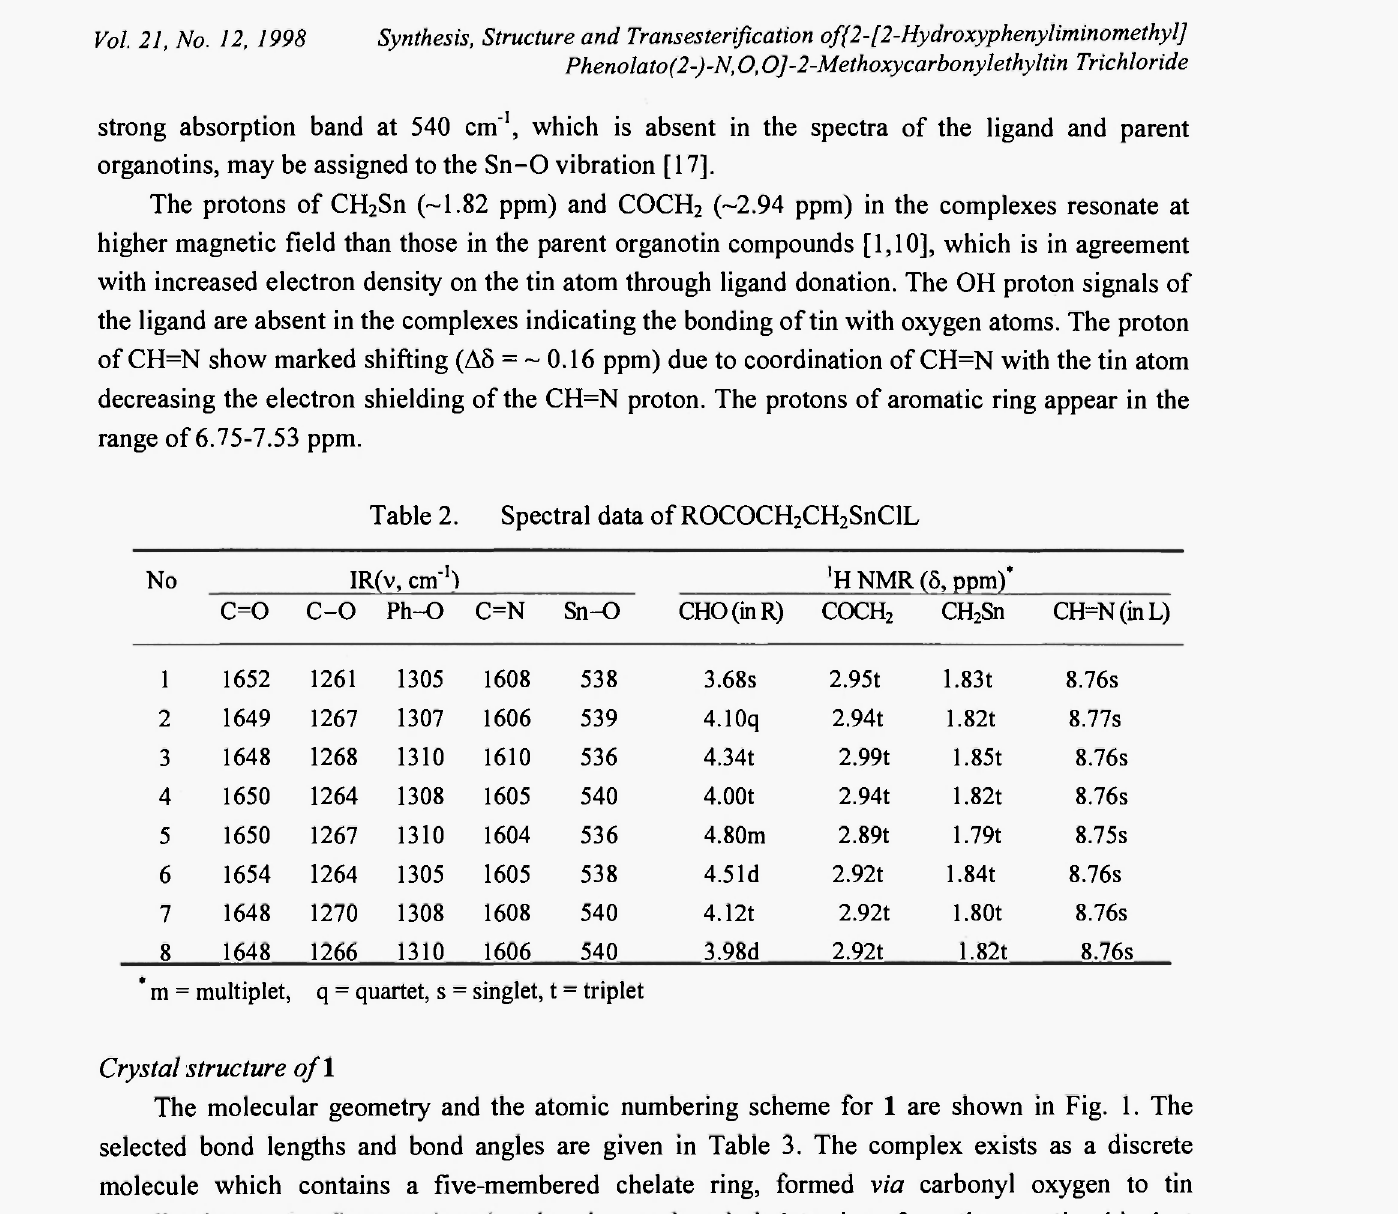
Spectral data of ROCOCH